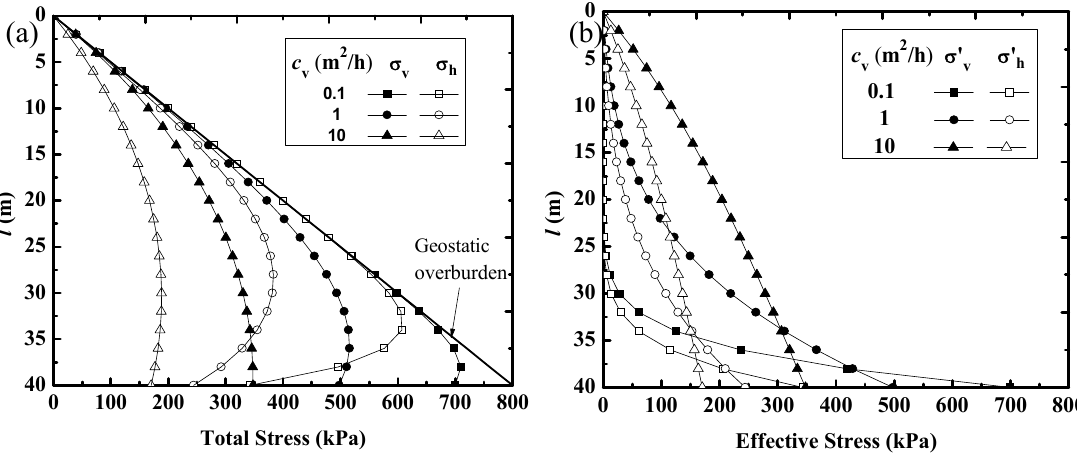
Figure 6. Distribution of the horizontal and vertical total ( a ) and effective ( b ) stresses with different consolidation coefficient c v along the full height of the stope at the end of backfill accreting deposition, predicted by the proposed solution (Equations (28)–(31)) by using: H = 40 m, B = 6 m, γ w = 10 kN/m 3 , γ = 20 kN/m 3 , m = 0.2 m/h, ϕ ’ = 20°, and K = K a ).